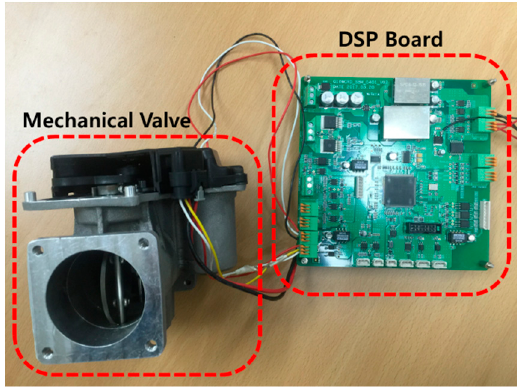
Figure 8. Experiment setup. Table 1. Motor parameters.